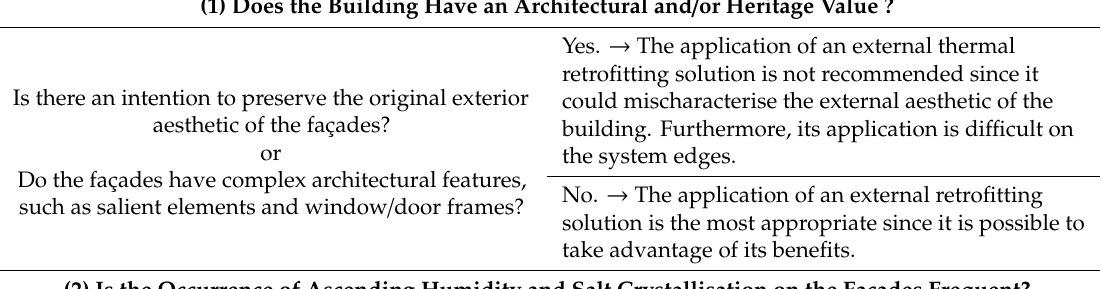
Table 4. Detailed information about the critical points of the